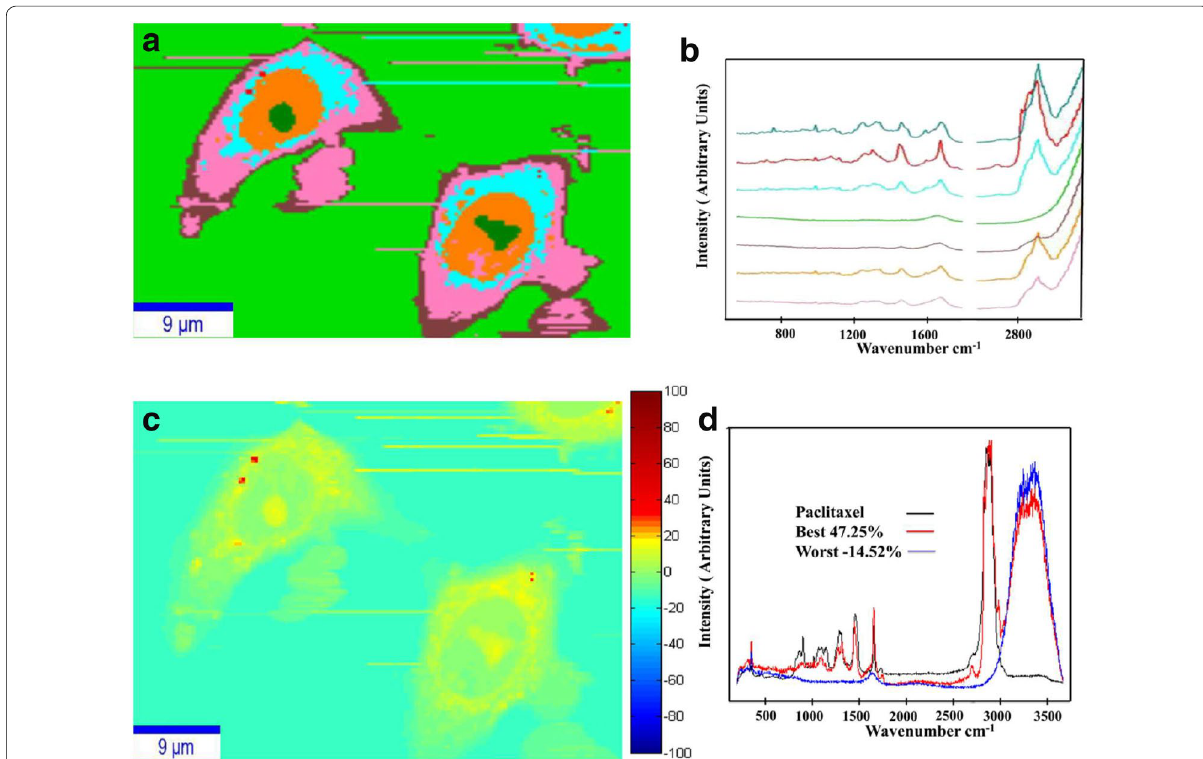
Fig. 12 a Seven cluster Raman map of MCF‑7 cells. b Average spectra corresponding to clusters in ( a ) (same colors as in ( a )): the average spectra of nucleus (orange) nucleolus (dark green), cytoplasm (pink), membrane (brown), endoplasmic reticulum (light blue), PBS buffer (light green) and paclitaxel (red). c Correlation map of the same image. d The correlation coefficient between the whole spectra and the one of paclitaxel taken as a reference (black spectrum). The best correlation is obtained for the paclitaxel in cell (red spectrum); the region with no correlation to paclitaxel is due to the PBS buffer (blue spectrum) (Reprinted with permission from [120]. Copyright @ 2013